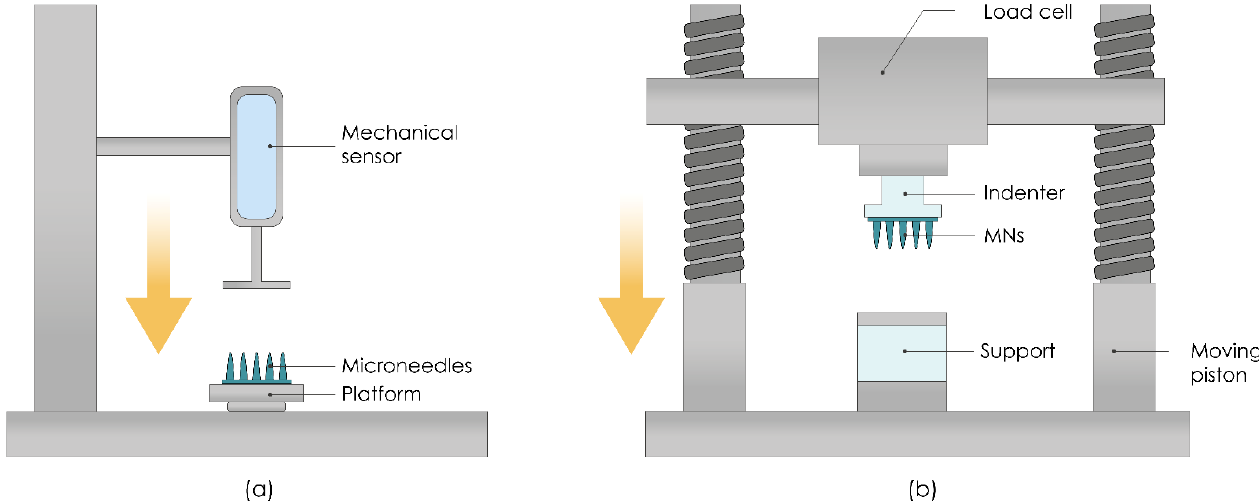
Figure 9. A schematic representation of ( a ) texture analyzer set up for the determination of fracture forces of MN arrays. Reproduced with permission from [186], Elsevier, 2017. ( b ) microneedle penetration testing. Reproduced with permission from [187], Elsevier, 2012. The image was created with Adobe Illustrator CC (Version 23.0.1.; Adobe Inc., San Jose, CA, USA, 2019).